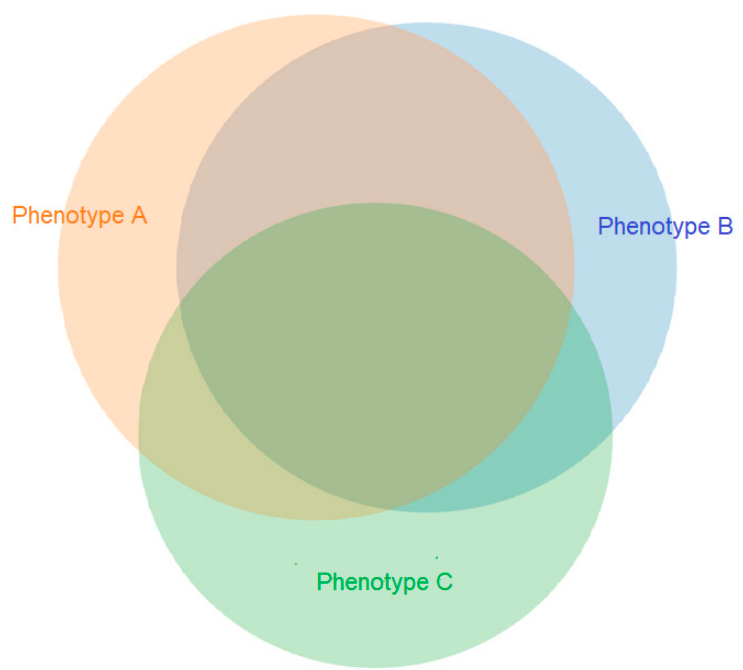
Figure 1. Distribution of QST and CPM phenotypes ( n = 106). Phenotype A, Presence of allodynia and/or temporal summation; Phenotype B, presence of pressure pain sensitivity; Phenotype C, CPM inefficient or suboptimal endogenous inhibitory pain response. Only 5 patients had none of the pain phenotypes present (results within normal limits).